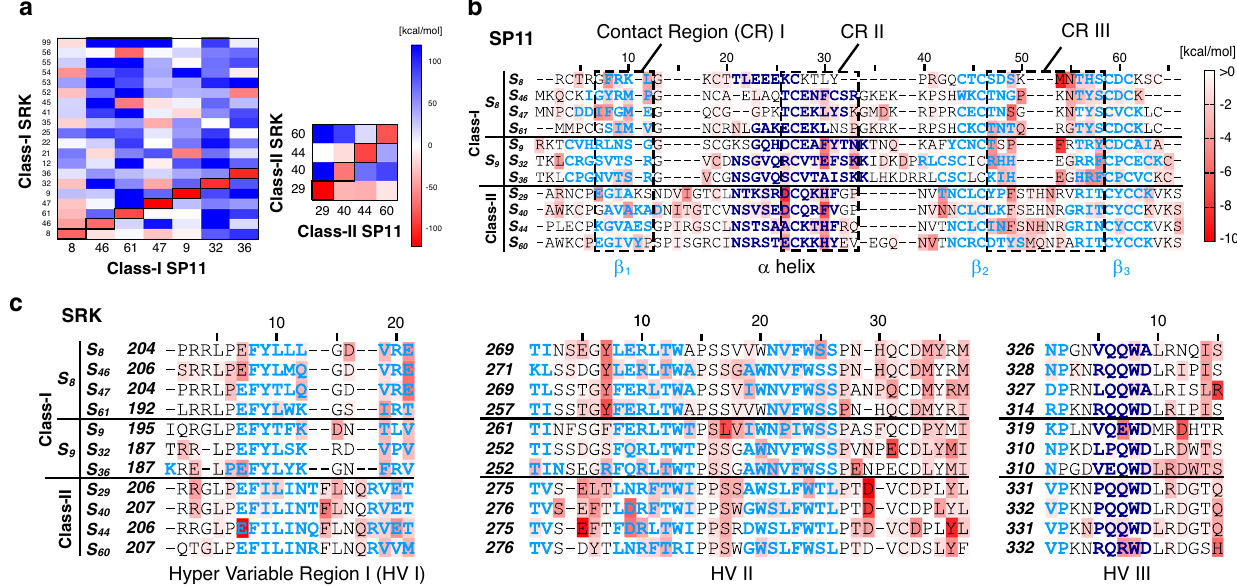
Fig. 3 MM – GBSA analysis using our modeled eSRK – SP11 complexes. a Calculated Δ G values for modeled SP11s against eSRKs. Red rectangles represent tightly bound eSRK – SP11 pairs, and white to blue rectangles represent pairs with weak af fi nity. These values were calculated by the MM – GBSA method. b , c Sequence alignments of SP11 ( b ) and the hypervariable regions (HVs) of SRK ( c ) haplotypes with heat maps indicating energy contributions from each residue. Residues consisting of an α -helix and β -strands are shown in dark and light blue, respectively. These alignments were generated using PROMALS3D 70 .